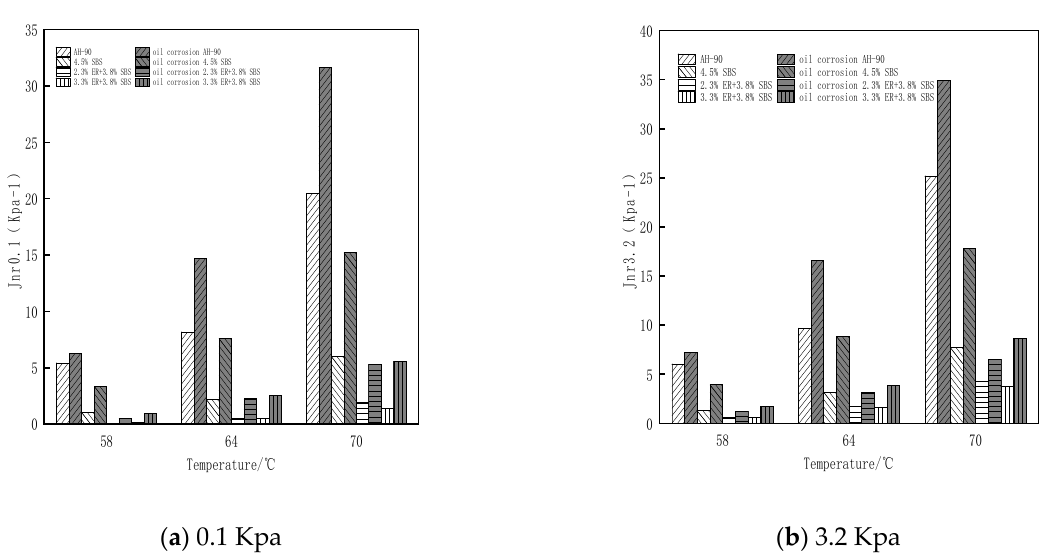
Figure 16. Changes in the flexible amount of irrecoverable creep of each bitumen after oil corrosion.